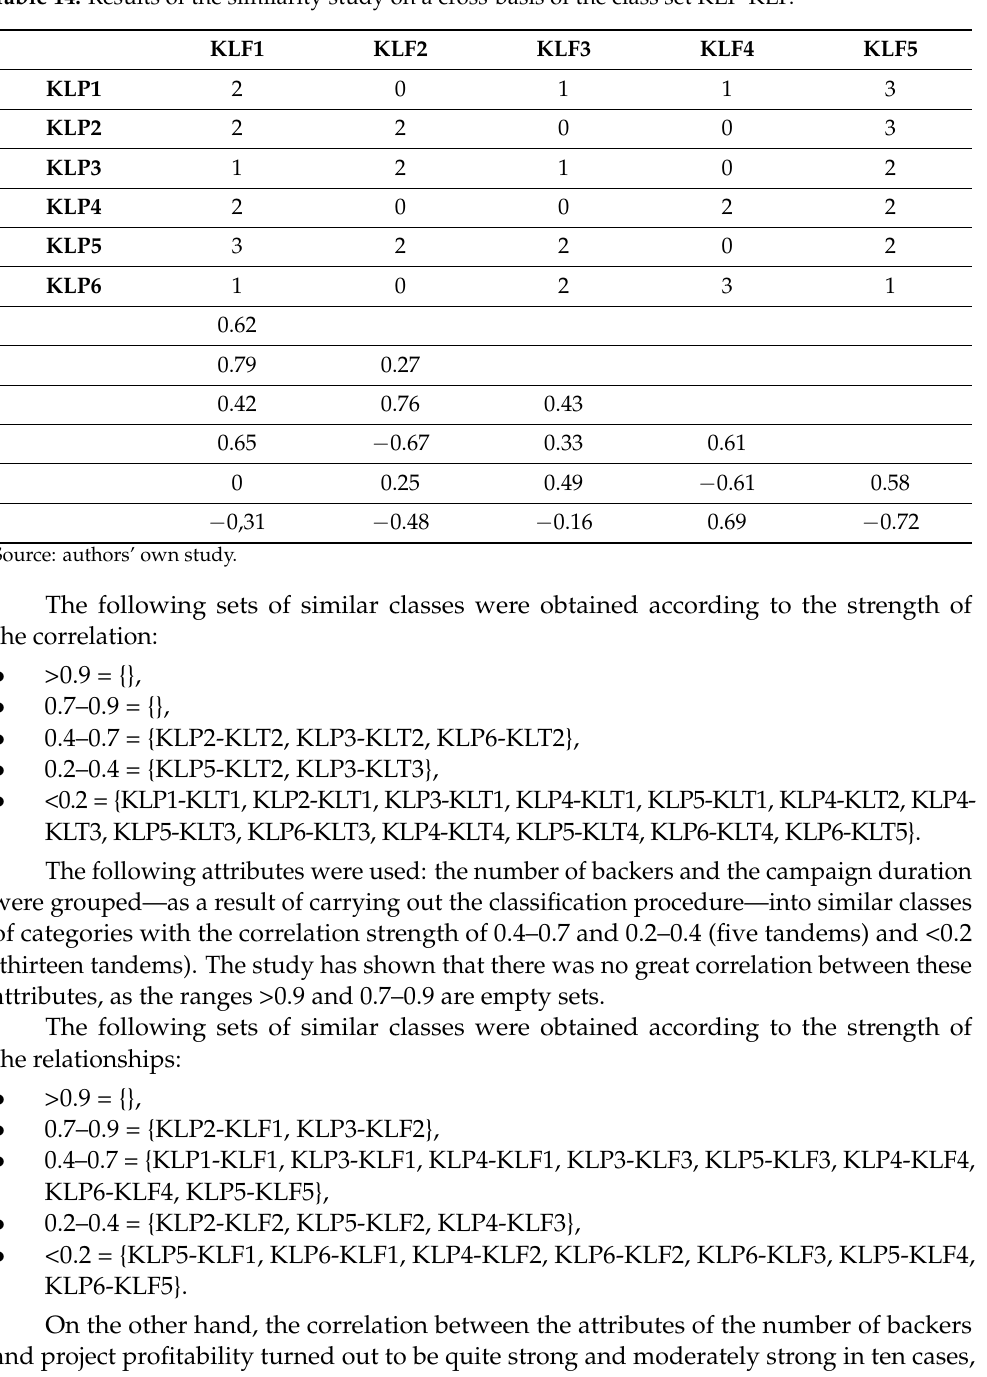
Table 14. Results of the similarity study on a cross-basis of the class set